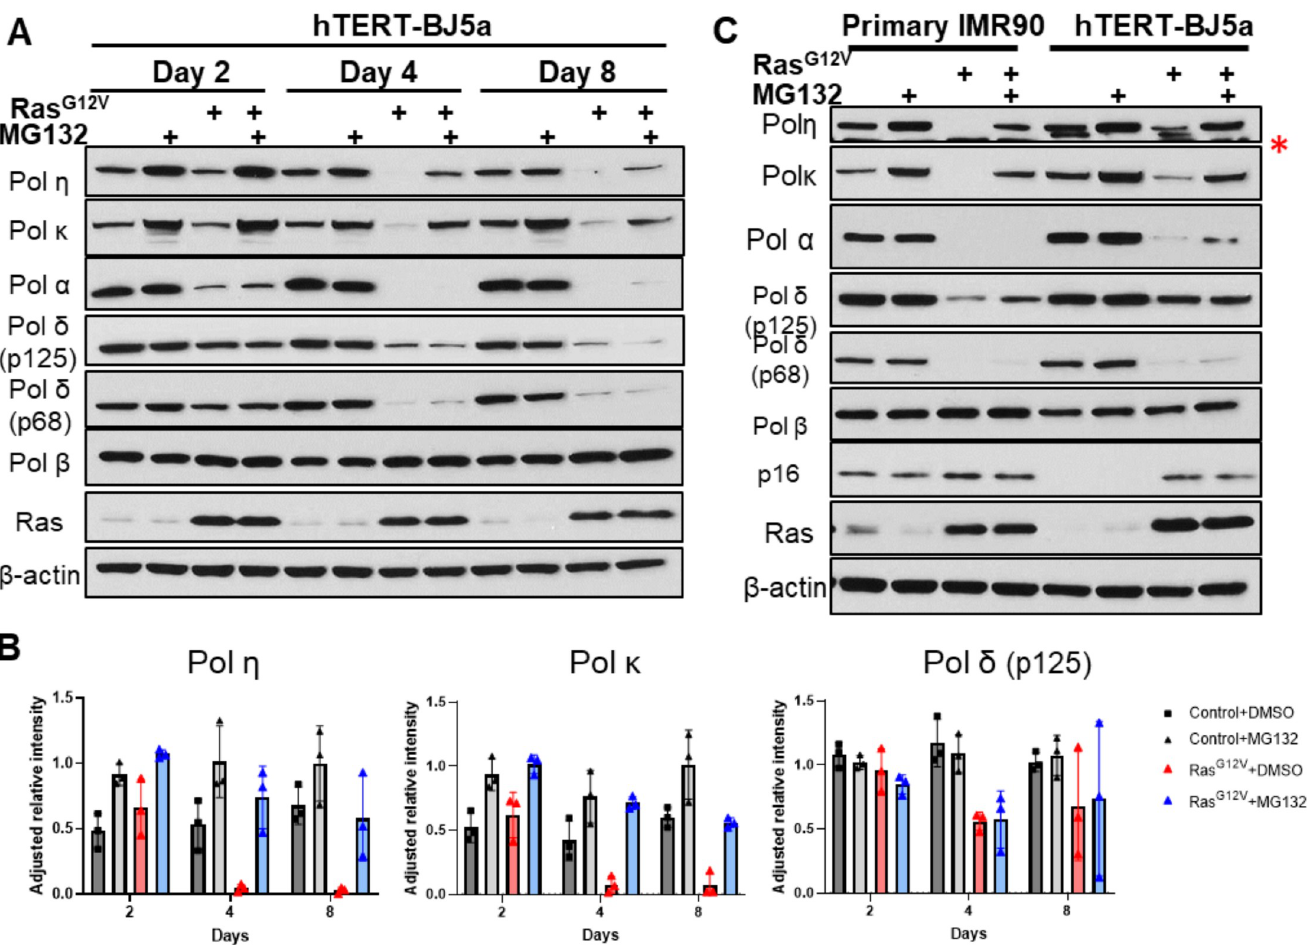
Fig 3. DNA polymerases η and κ levels are regulated by the proteasome degradation pathway. (A) Immunoblot analyses of polymerase levels at indicated days after transduction and selection with control or Ras G12V vectors. h-TERT BJ5a cells were either treated with DMSO or MG132 (10 μ M) for 4 hours prior to harvesting. Immunoblot analysis represent one of three biological replicates (see S1 Fig for additional replicates). (B) Relative polymerase levels in BJ5a cells. Adjusted relative intensity values were calculated using ImageJ; data are from three biological replicates. (C) Side-by-side comparison of primary fibroblast IMR90 and BJ5a cells infected with control or Ras G12V at day 8. Cells were treated with DMSO or MG132 (10 μ M) for 4 hours prior to harvest. The BJ5a results shown here are an independent biological replicate of Fig 3A. � Asterisk indicates a non-specific band.